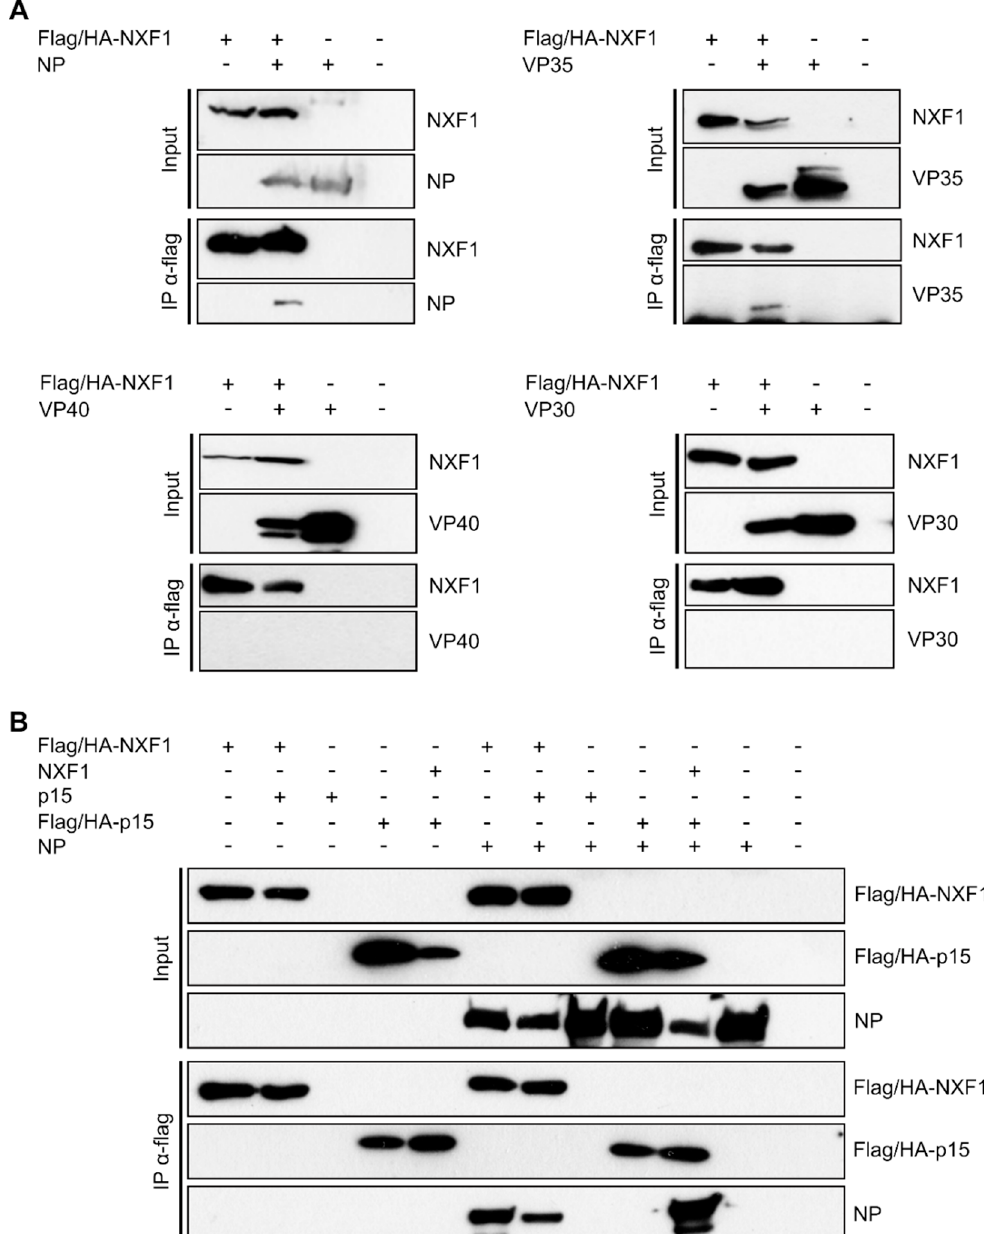
Figure 1. Interaction of NXF1 with nucleoprotein (NP) and VP35. ( A ) Immunoprecipitation of NXF1 and coIP of viral proteins. 293T cells were transfected with the plasmids encoding for flag/HA-NXF1 and one of the viral proteins NP, VP35, VP40 or VP30. Forty-eight hours p.t. flag/HA-NXF1 was precipitated using anti-flag antibodies, and input and precipitates were analyzed via SDS-PAGE and subsequent Western blot. NXF1 was detected with anti-flag antibodies, and anti-NP, anti-VP35, anti-VP40 or anti-VP30 antibodies were used for the detection of the respective viral protein. In case of the VP35 blot, the band at the lower edge of the blot that is partially cut off is caused by the light chain of the IP antibody. ( B ) Influence of p15 on the interaction between NXF1 and NP. Flag/HA-tagged NXF1 or p15 was precipitated from transfected 293T cells using anti-flag antibodies. Input and precipitate samples were subjected to SDS-PAGE and analyzed by Western blot using anti-flag antibodies for the detection of p15 and NXF1, whereas an anti-NP antibody was used for the detection of NP.